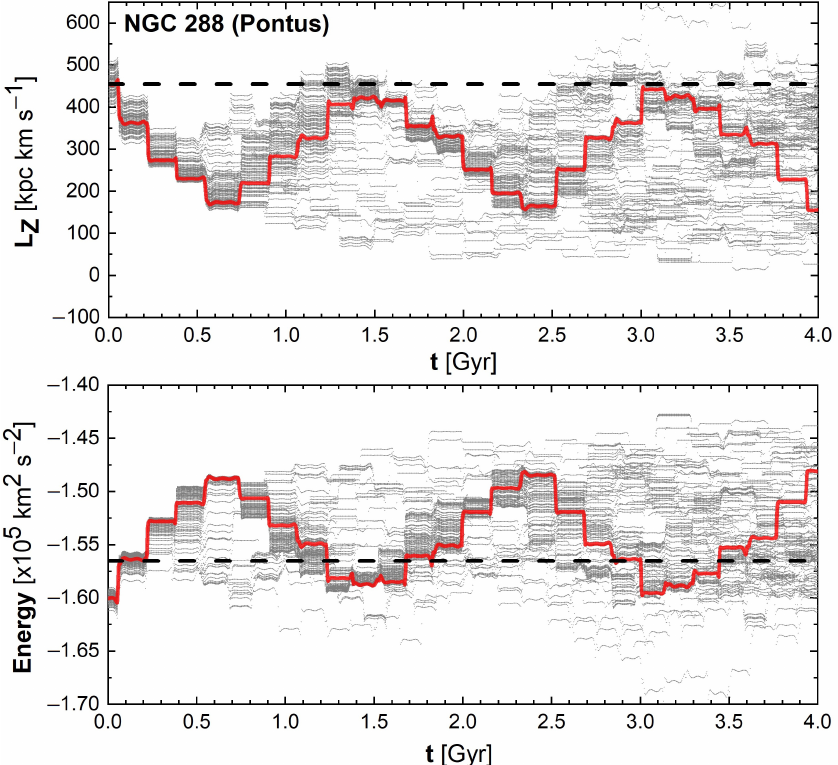
Figure 6. Evolution of the total energy E (bottom frame) and the z-component of angular momentum L z (upper frame) for the globular cluster NGC 288 evolving in the non-axisymmetric rotating potential of the bar. The red line shows the evolution for the mean value of initial conditions. The grey lines are one hundred representations of the orbits taking into account the observational errors in coordinates and proper motions. The black dashed line shows the constant angular momentum and energy in the axisymmetric McMillan17 potential. Time t = 0 means the start time of the simulation and corresponds to the present